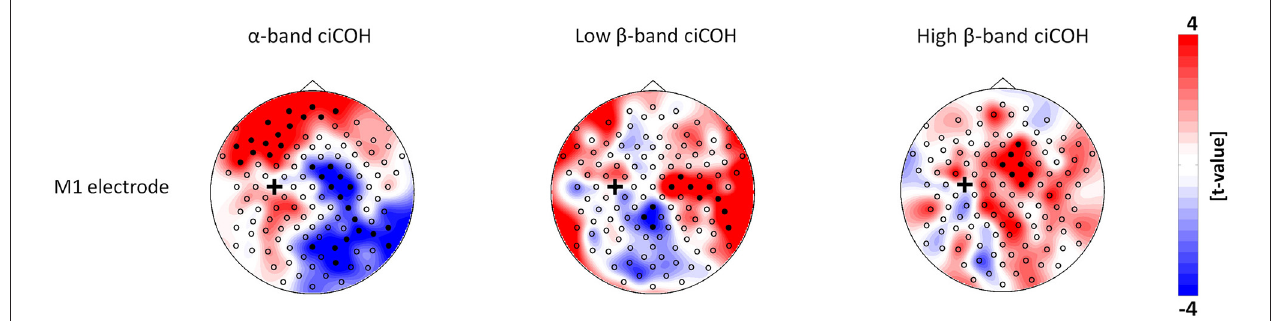
randomization test, are visualized by filled black circles. The black cross indicates the seed electrode position in the primary motor cortex (M1). Red color indicates increase and blue color decrease in functional connectivity (ciCOH) in the POST training as compared to PRE training condition.